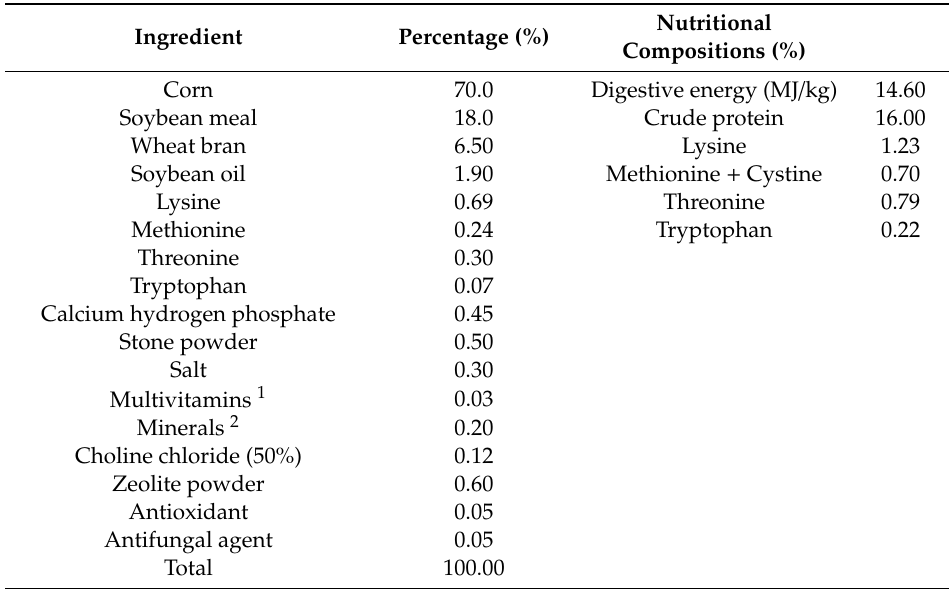
Table 1. Composition and nutrient level of the diet (air-dry